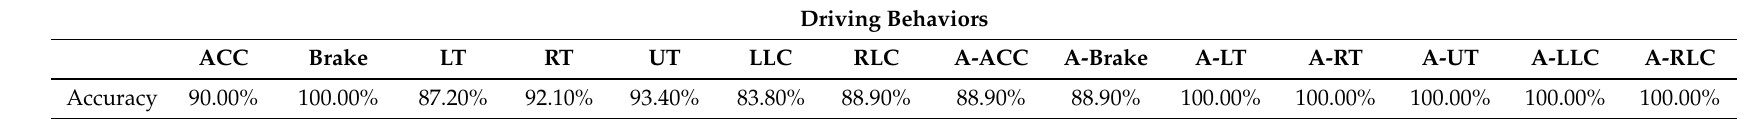
Table 9. The recognition rate of specific driving behaviors using SVM